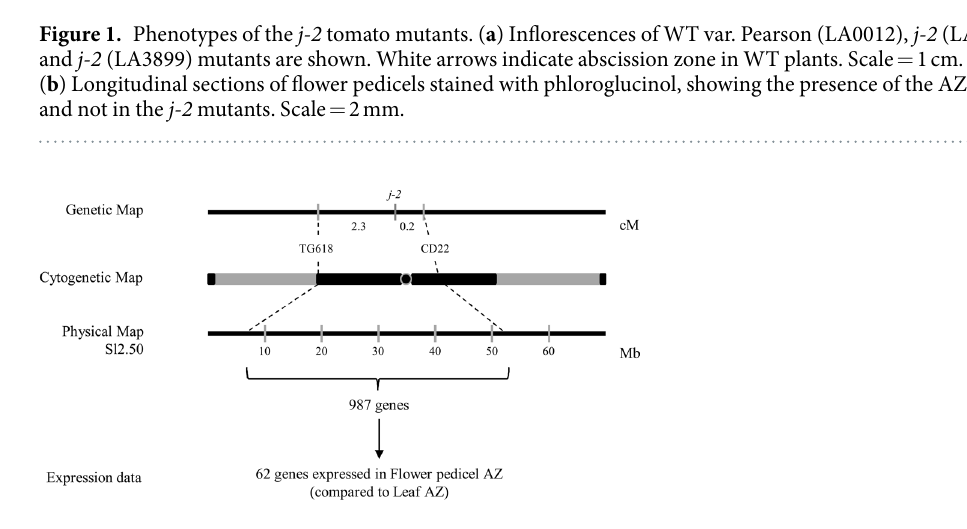
total of 987 genes in J-2 genetic interval (Fig. 2, Supplementary Fig. 4a). To reduce this large list to a minimum number of candidate genes, we carried out a meta-analysis of RNAseq data searching for genes that are highly expressed in the flower pedicel AZ compared to leaf AZ 26 . Among the 987 genes that physically mapped to J-2 interval, 62 were found as differentially expressed in the flower pedicel abscission zone (FAZ) compared to the leaf abscission zone (LAZ). We selected 8 of them, based on the expression level (average read depth on FAZ > 50) and the function of the encoded proteins (transcription factors, components of hormonal pathways, develop- mental genes) (Fig. 2, Supplementary Table 1). Among the 8 selected candidates, the gene that showed the most significant differential expression between LAZ and FAZ (Log2 ratio = − 8,41) was a MADS box transcription factor ( MADS11 , Solyc12g038510 ). The 7 other candidate genes encode transcription factors or hormone sig- naling regulators: a gibberellin-regulated protein ( Solyc12g042500 ), an aquaporin ( Solyc12g044330 ), a jasmon- ate ZIM domain-containing protein ( Solyc12g049400 ), a multidrug resistance protein ( Solyc12g019320 ), a C2 domain-containing protein ( Solyc12g040800 ), a SQUAMOSA promoter binding protein ( Solyc12g038520 ) and a MYB transcription factor ( Solyc12g044610 ). To further reduce the list of candidate genes, we compared their expression levels in WT and j-2 mutants (Fig. 3). cDNA was prepared from pedicel segments harvested where the AZ formed (WT) or should have formed ( j-2 ), at the time of flower anthesis. The transcript levels of two candidate